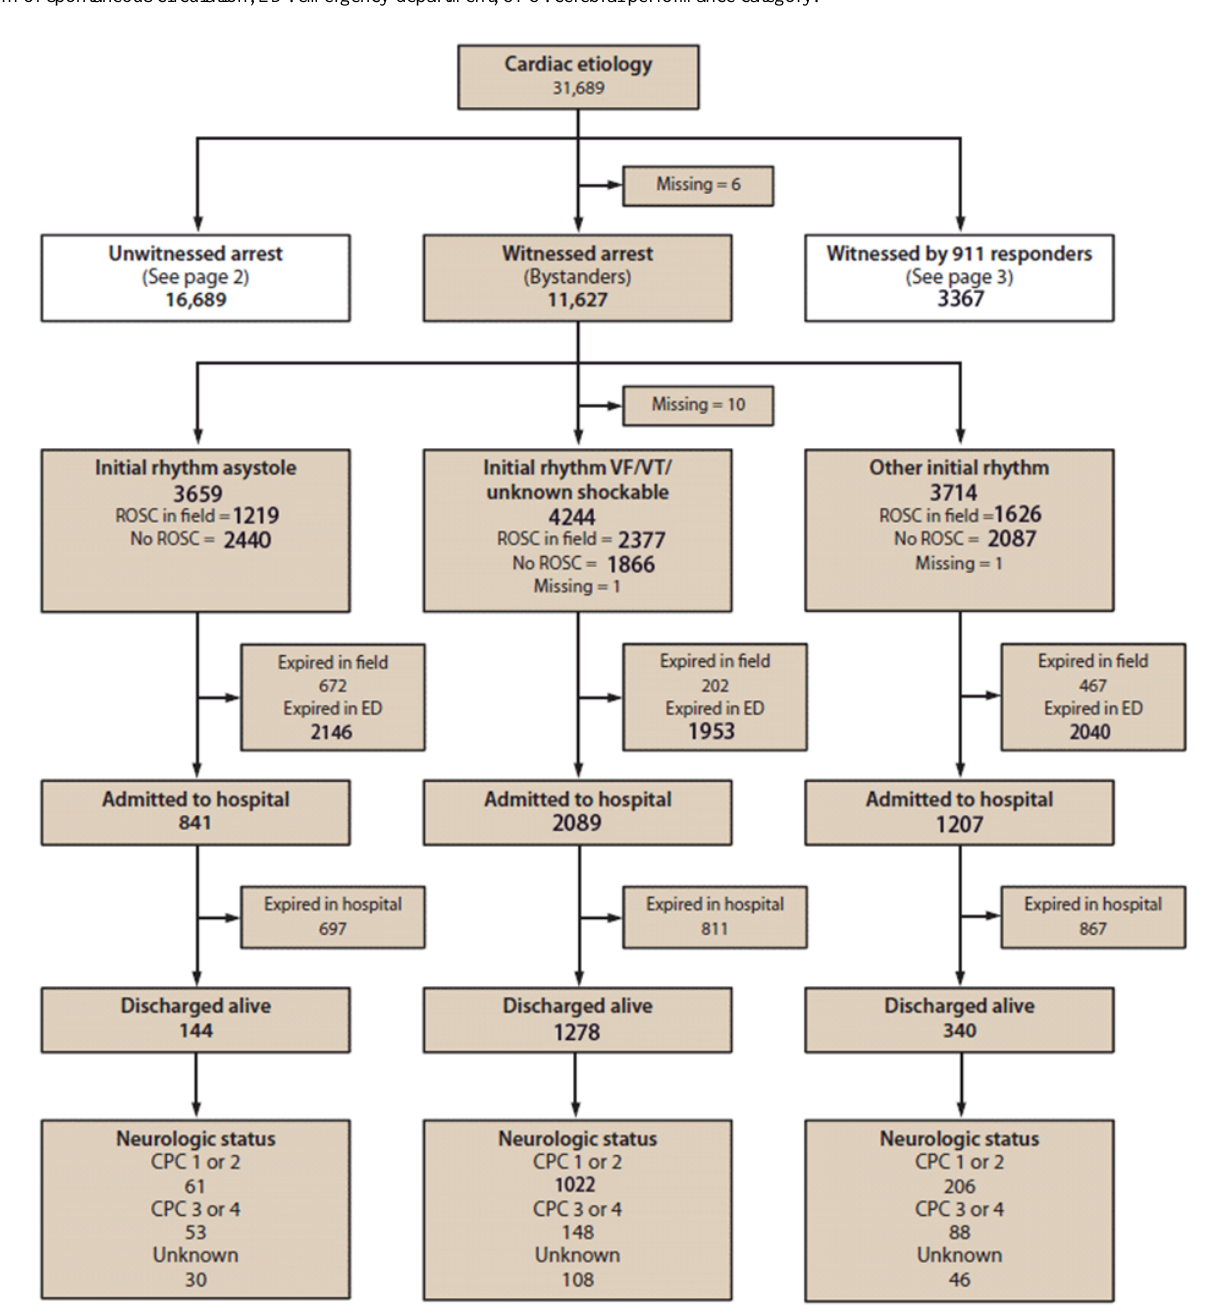
Figure 2. Network structure of a complex system centered on cardiac emergency decision making. VF: ventricular fibrillation, VT: ventricular, ROSC: return of spontaneous circulation, ED: emergency department; CPC: cerebral performance